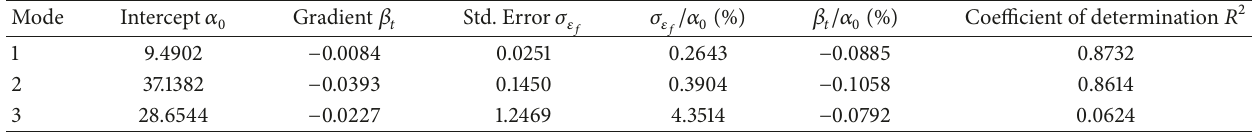
Table 5: Coefficients of linear regression model (frequency ∼ humidity) of girder No. 1.